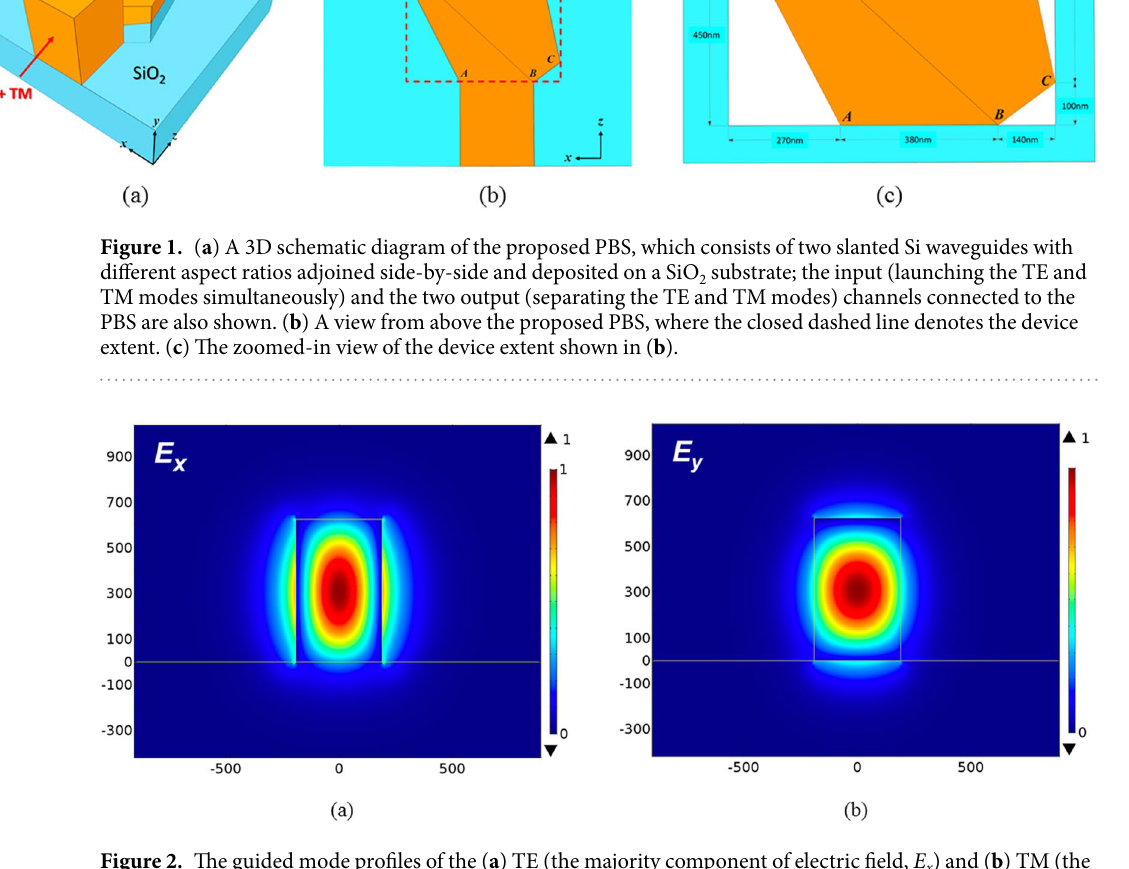
Figure 2. The guided mode profiles of the ( a ) TE (the majority component of electric field, E x ) and ( b ) TM (the majority component of electric field, E y ) modes at the input